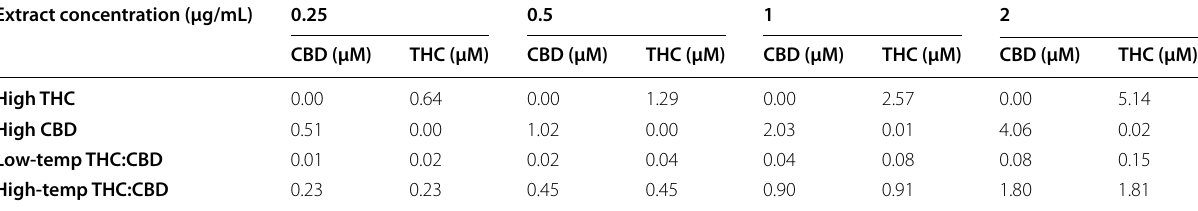
Table 2 Calculated equivalent levels of pure THC and CBD (μM) found in the cannabis extracts at 0.25, 0.5, 1, and 2 μg/mL Extract concentration (μg/mL)